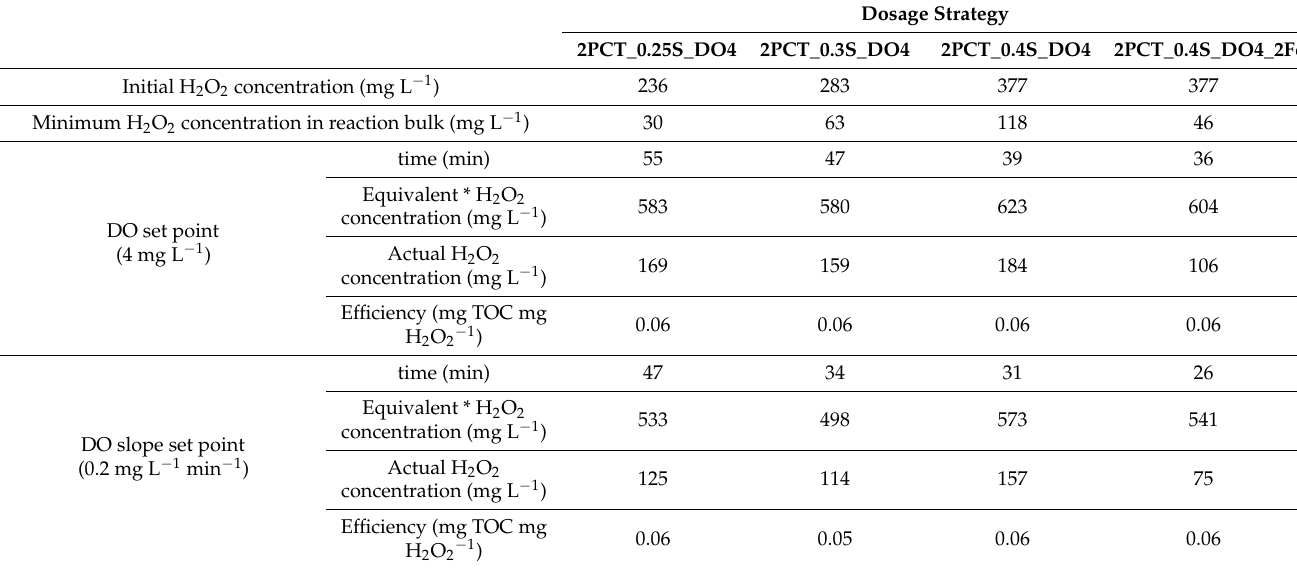
Table 3. Information for each dosage strategy studied about H 2 O 2 addition/evolution, reaction time and efficiency needed to reach the proposed set points when PCT concentration was doubled up to 126 mg L − 1 TOC. Dosage Strategy 2PCT_0.25S_DO4 2PCT_0.3S_DO4 2PCT_0.4S_DO4